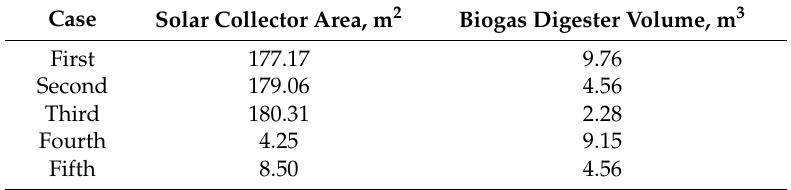
Table 4. The required solar collector area and biogas digester volume for bio-solar